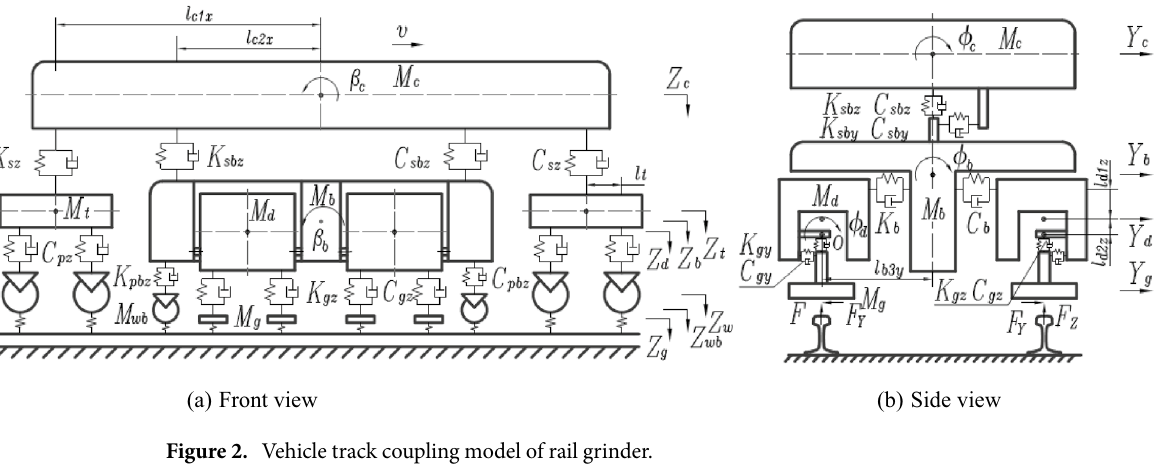
Figure 2. Vehicle track coupling model of rail